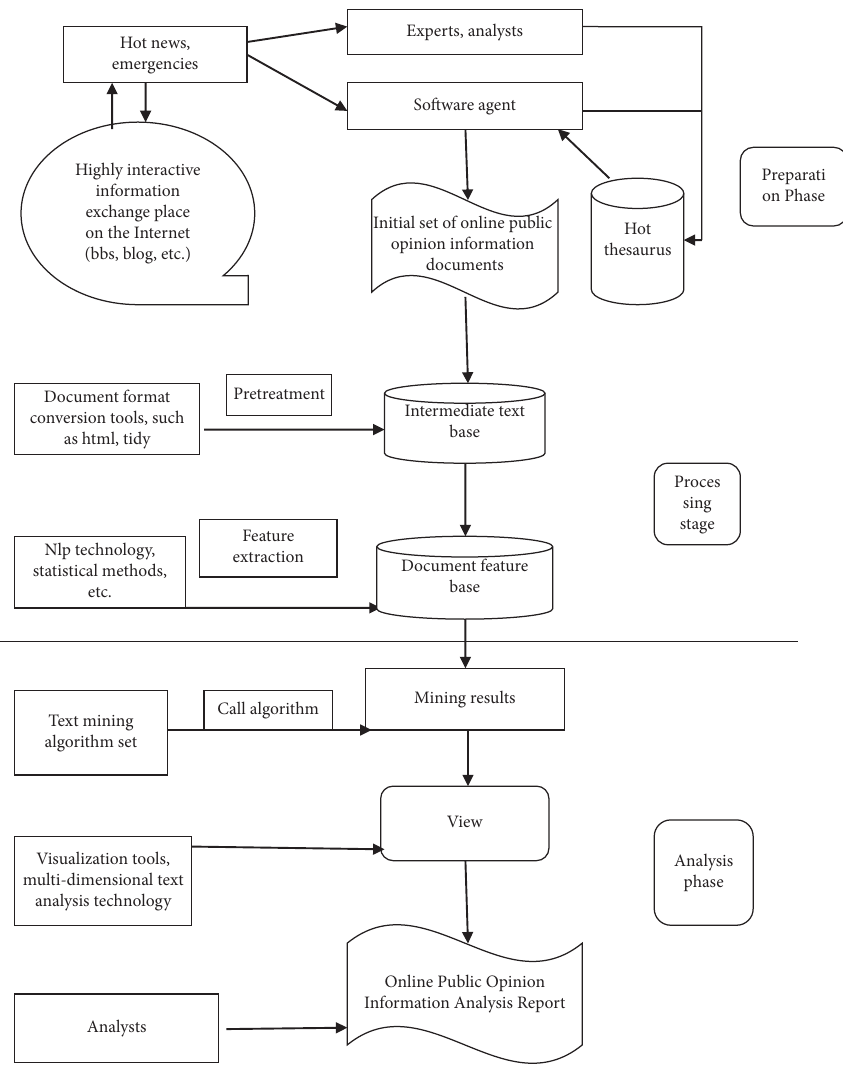
Figure 1: Multi-source text mining